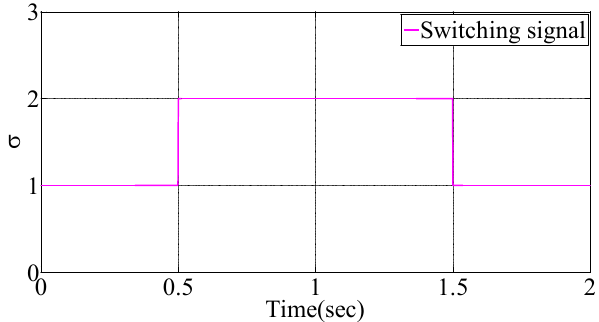
Figure 9. This is a switching signal that triggers twice switching within 2 s , at 0.5 s and 1.5 s respectively. σ denotes the phase of the exoskeleton. (value 1 denotes the swing phase and 2 denotes stance phase.)